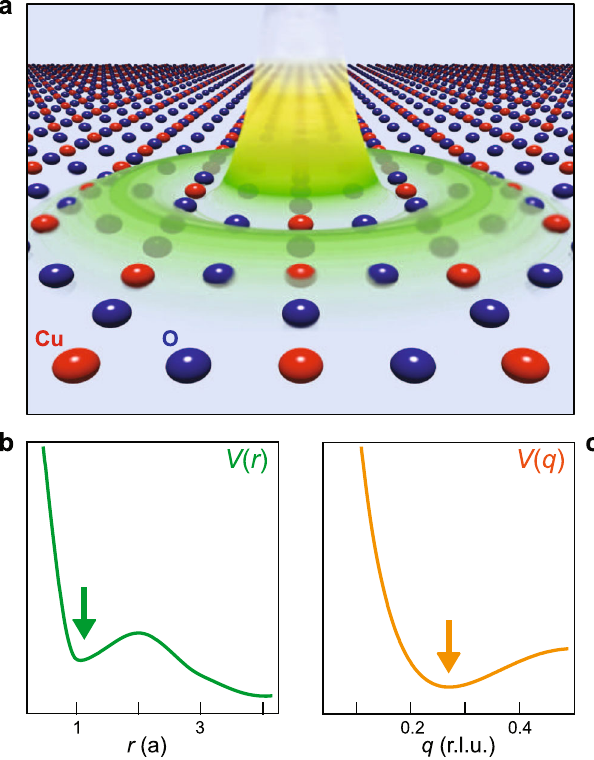
Fig. 4 Non-monotonic Coulomb interactions. a Pictorial representation of the Coulomb interaction potential V ( r ) in the CuO 2 plane. The Coulomb potential created by an electron at a Cu site is non-monotonic at the length scale of a few lattice units a (Cu – Cu distance) due to a non-uniform polarizability that weakens the short-range electron – electron interactions. b , c Schematic pro fi les of V ( r ) and V ( q ) along the Cu – O bond direction. The arrows highlight a minimum at approximately a (green) and q ≈ 0.27 rlu (orange),